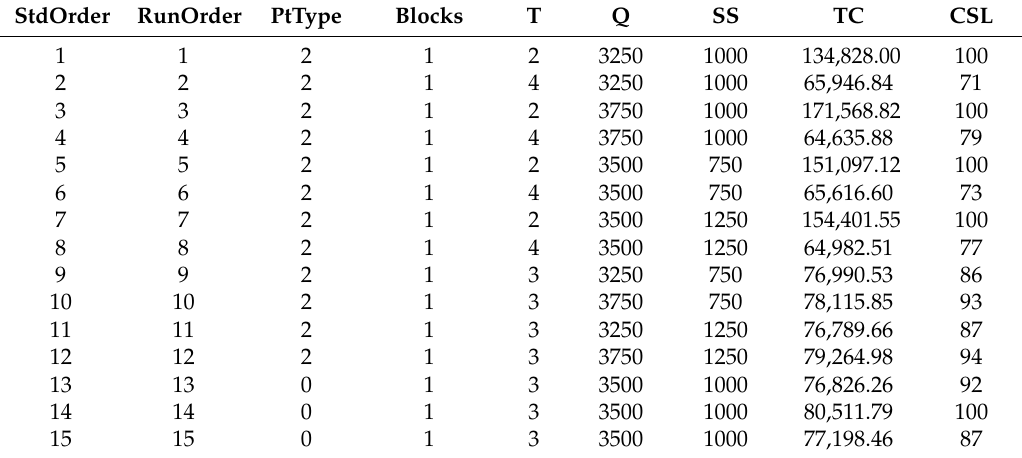
Table 6. Box–Behnken design (three continuous factors).